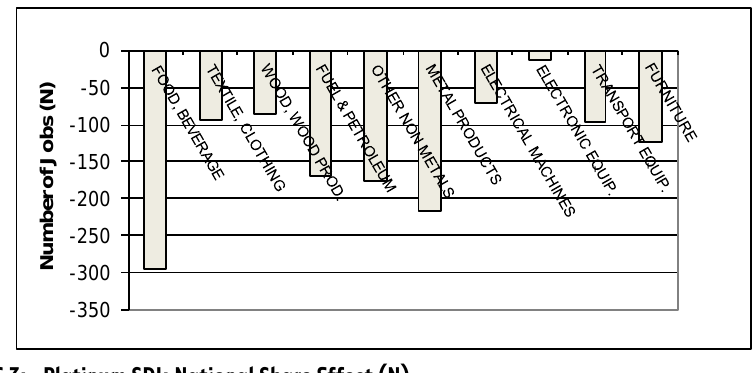
FIGURE 3: Platinum SDI: National Share Effect (N) Source: